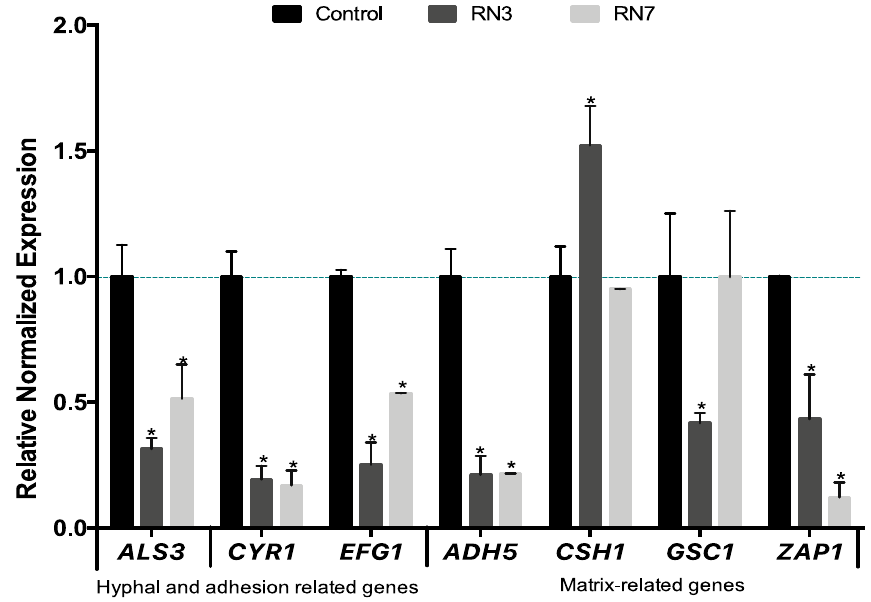
Figure 7. Quantitative RT-PCR analysis of C. albicans biofilm-related genes after 10 µ M of RN3 and RN7 treatment. C. albicans biofilms, at early stage of development (90 min), were incubated in the presence or absence of both hRNase-derived peptides during 24 h, and then assessed by qPCR analysis. The relative levels of gene expression are presented as fold changes in peptide-treated groups (RN3 peptide in dark grey and RN7 peptide in light grey) with respect to the untreated controls in black. All gene transcript levels were normalized against ACT1 gene expression (pointed line). Statistically significant results were evaluated by ANOVA test, followed by Dunnett’s Multiple Comparison Test. * p < 0.001 indicates significant differences between peptide- treated and control groups.